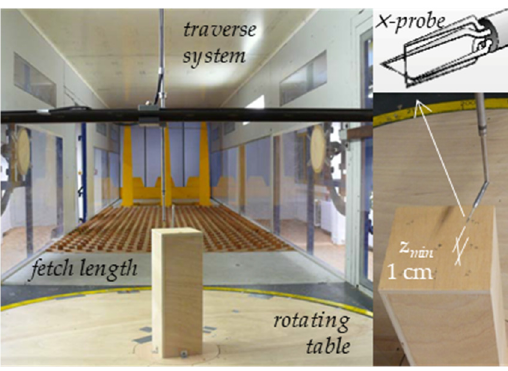
Figure 2. Wind Tunnel of the Ruhr-University Bochum [32].